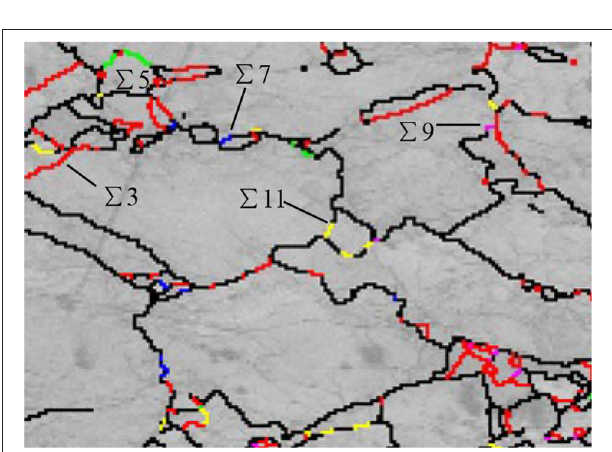
FIGURE 10 | CSL boundaries in OIM map for deformed sample at critical strain (0.22). The high angle and 6 3 twin boundaries are shown as black and red lines,